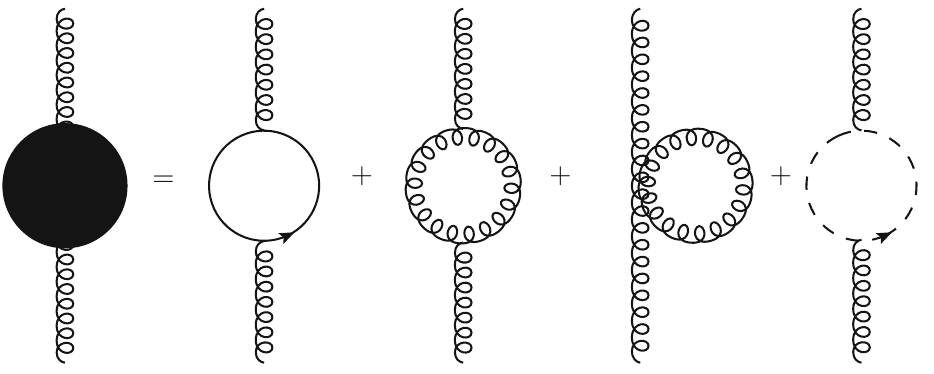
Fig. 6 One-loop gluon self energy